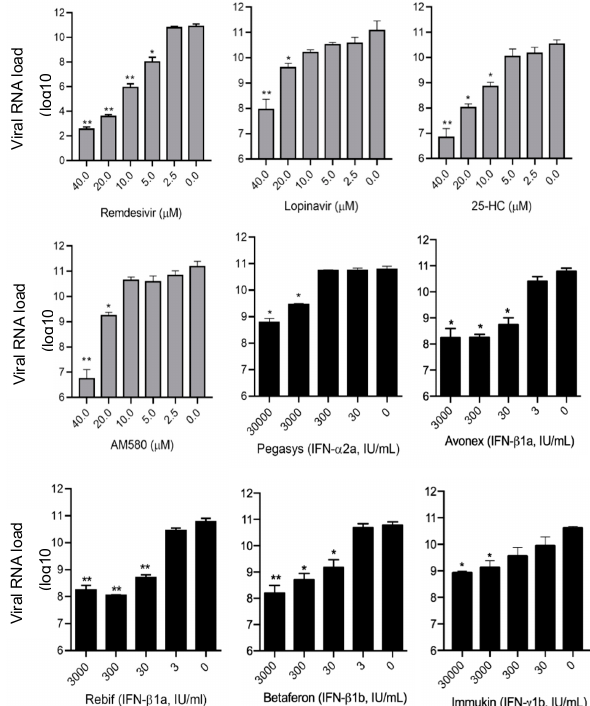
Figure 3. SARS-CoV-2 viral load reduction assay. VeroE6 cells were infected with SARS-CoV-2 (multiplicity of infection = 0.01) and treated with different concentrations of the selected antiviral agents as indicated. The culture supernatants of the SARS-CoV-2-infected cells were harvested at 48 h post-inoculation for quantitative reverse transcription-polymerase chain reaction analysis to determine the viral RNA load. * indicates p < 0.05 and ** indicates p < 0.01. The results are presented as mean ± standard deviations. The experiments were performed in triplicate and repeated twice for confirmation. Abbreviation: 25-HC,